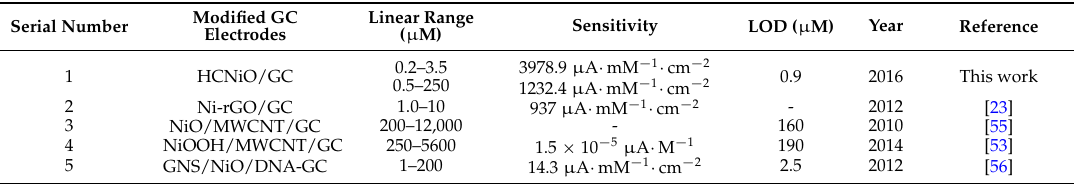
Table 1. Comparison of non-enzymatic glucose sensors’ analytical parameters for different nickel-based glassy carbon electrodes (GCEs).